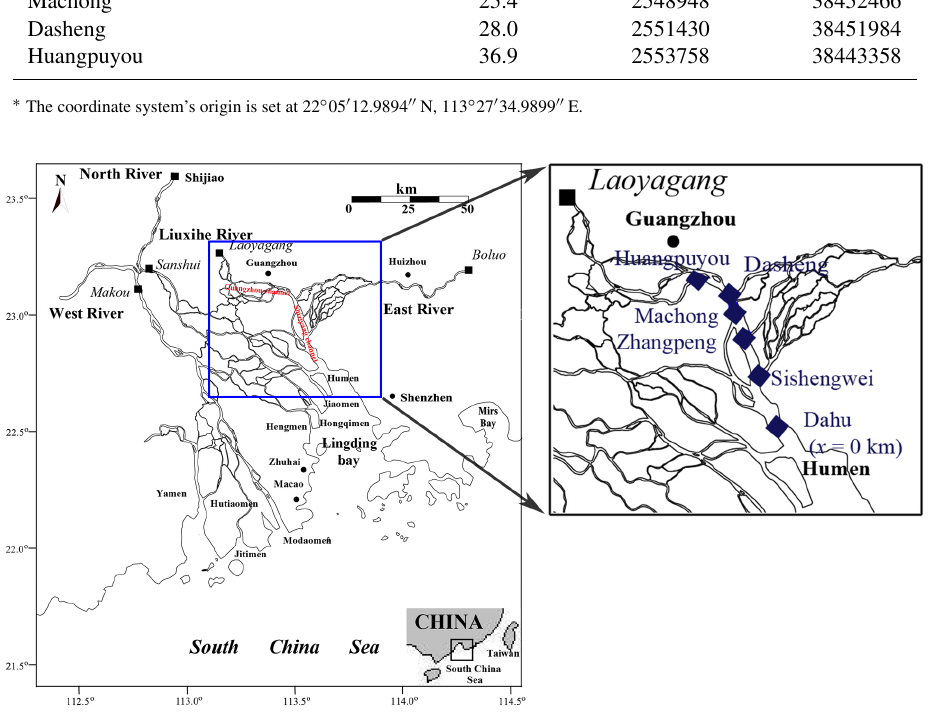
Figure 1. Map of the Humen estuary, showing the gauging stations where salinity concentration was measured during the field survey from 29 January to 3 February